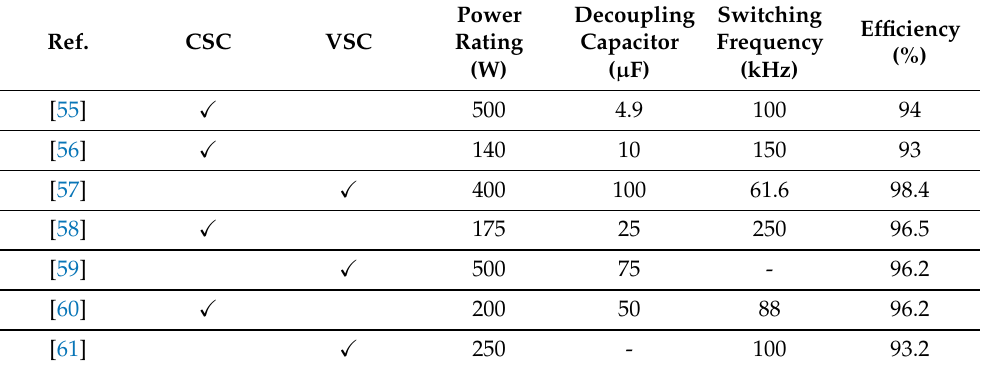
Table 3. Characteristics of DC-DC quasi-resonant power